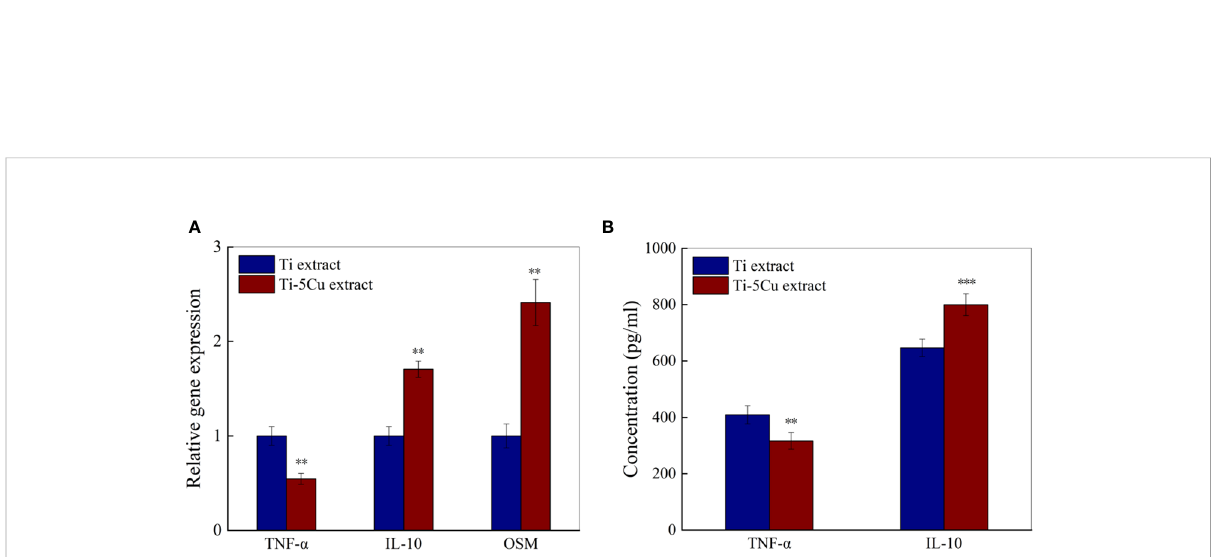
FIGURE 7 The gene and protein expressions of in fl ammatory and osteogenic cytokines in RAW264.7 cells after cultured with Ti and Ti-5Cu extracts for 72h. (A) The gene expressions of RAW264.7 cells by RT-qPCR; (B) The protein expressions of RAW264.7 cells by ELISA(n = 3; **p < 0.01 and ***p <